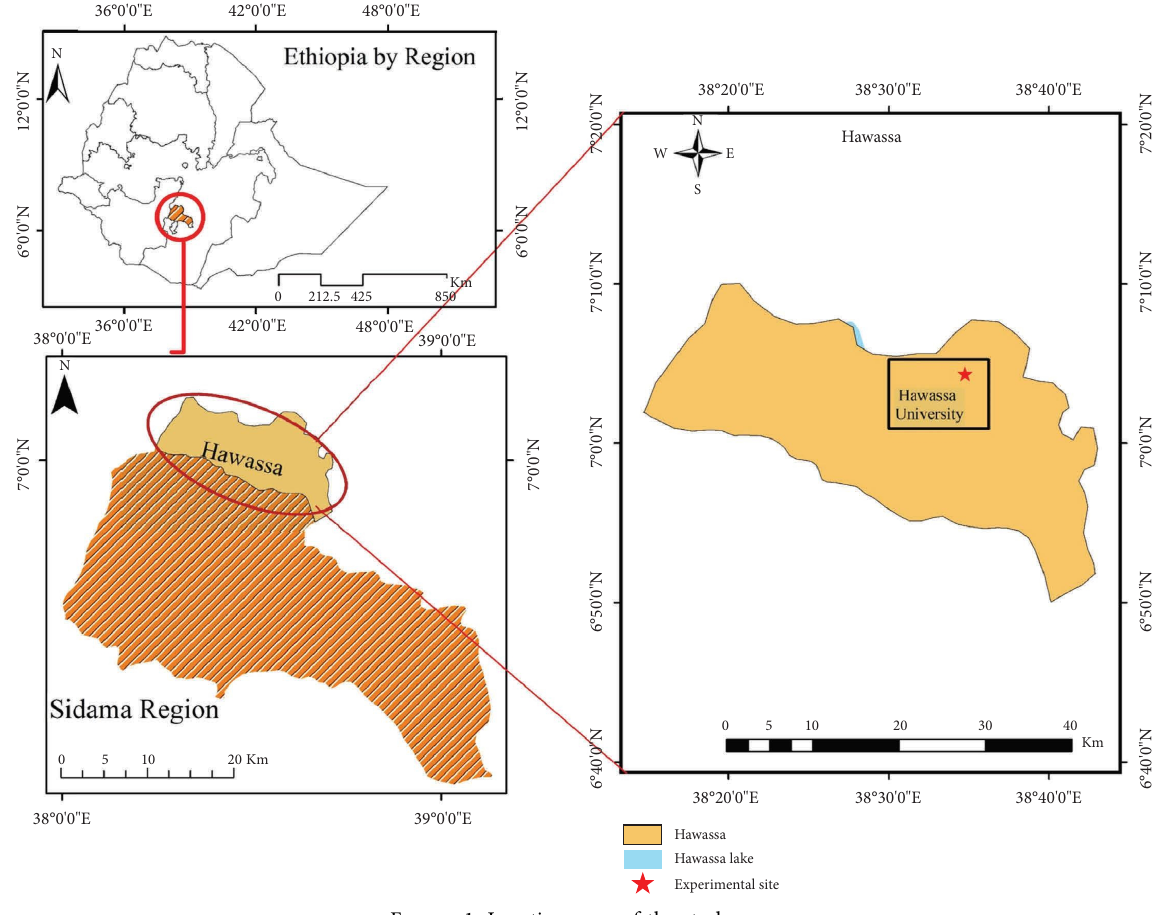
Figure 1: Location map of the study